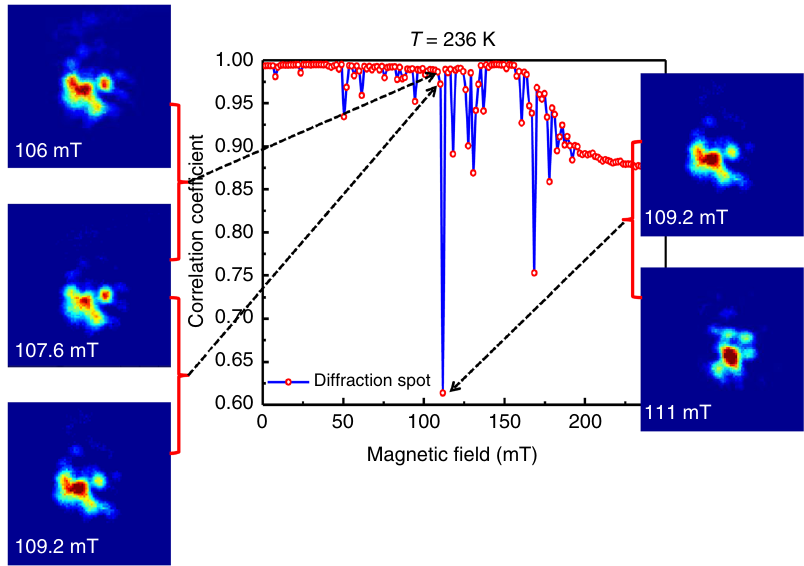
Fig. 3 Pair-wise correlation coef fi cient: Pair-wise correlation function (blue line) versus perpendicular magnetic fi eld. We show the speckle pattern at T = 236 K for four consecutive fi eld values that produces small and big jumps. The speckle patterns are represented within an area of 90 by 90 pixels. Large change in speckle pattern gives rise to large magnitude of jump indicating a large change of domain morphology